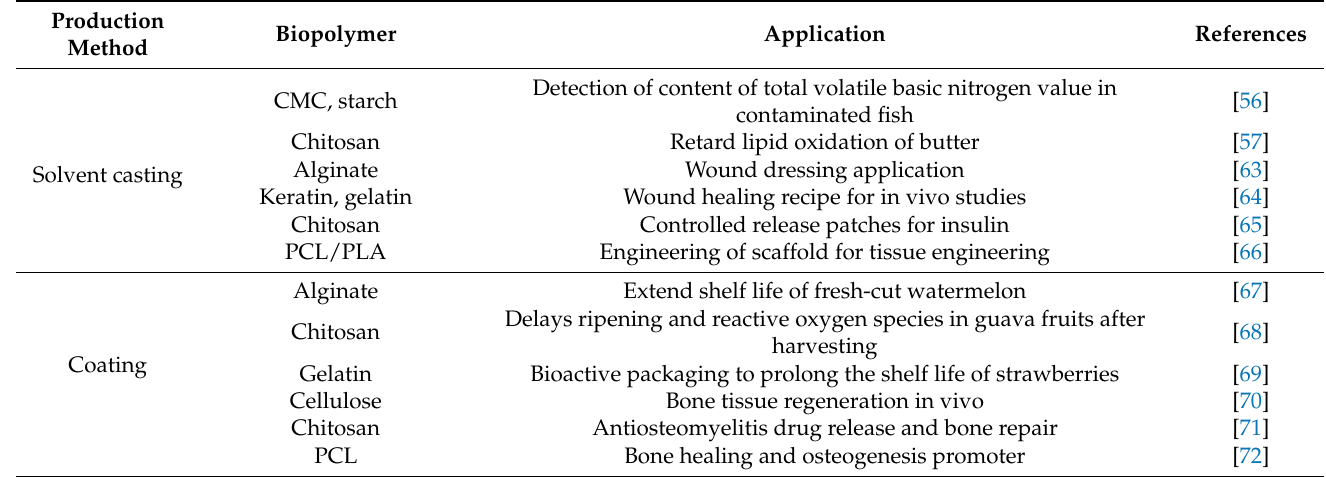
Table 1. Methods of biopolymer processing and applications. CMC is carboxymethylcellulose, PLA is polylactic acid, PHA is polyhydroxyalkanoate, and PCL is